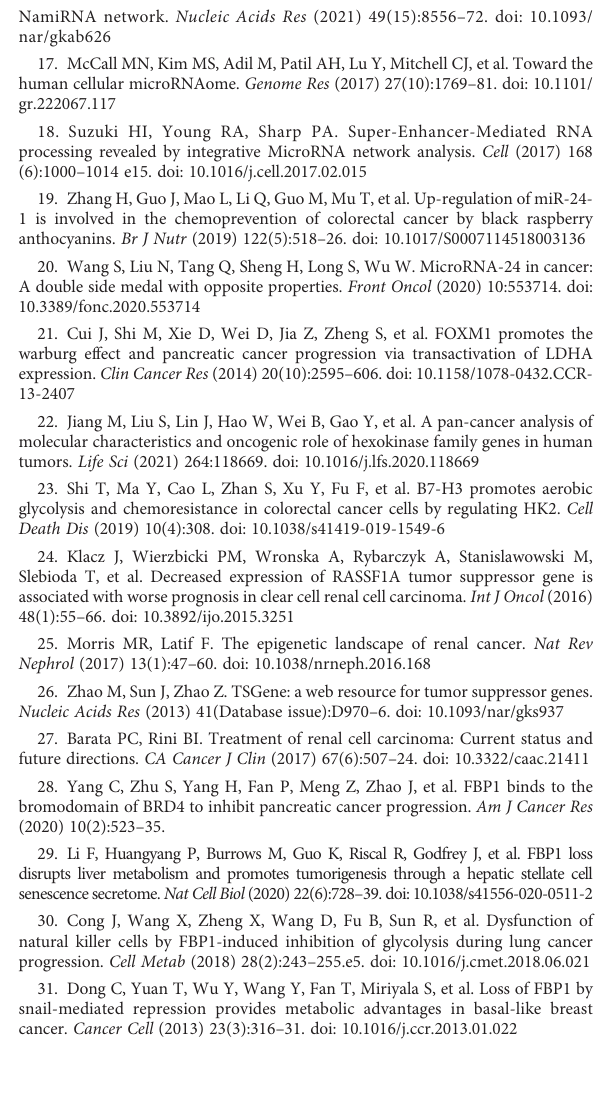
SUPPLEMENTARY FIGURE 1 miR-24-1 inhibitor declines the expression of FBP1 and promotes the proliferation and migration of RCC cells. (a, b) qPCR assay was performed to con fi rm that the expression of miR-24-1 was successfully declined after transfecting miR-24-1 inhibitor, and FBP1 was accordingly downregulated in ACHN (a) and 786-O (b) cells. (c, d) The proliferation ability of 786-O (c) and ACHN (d) cells was promoted after transfecting miR-24-1 inhibitor in CCK8 assay. Results are shown as mean ± S.D. of triplicated experiments, ****p < 0.0001, **p < 0.01, *p<